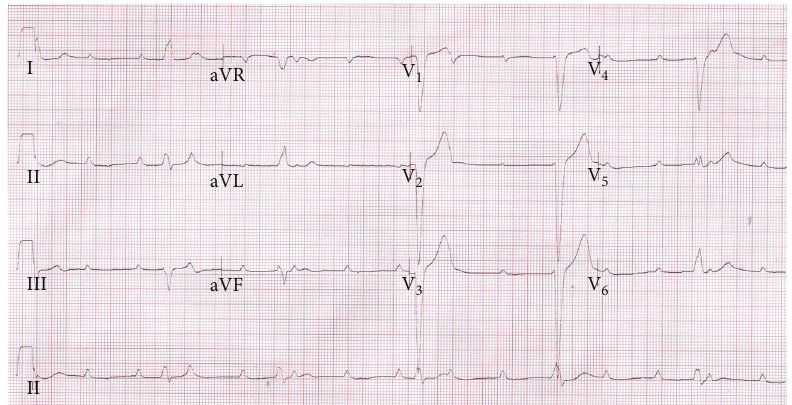
Figure 2: ECG for patient 2 on day 7 of admission showing CHB with ventricular rate approximately 35 bpm.